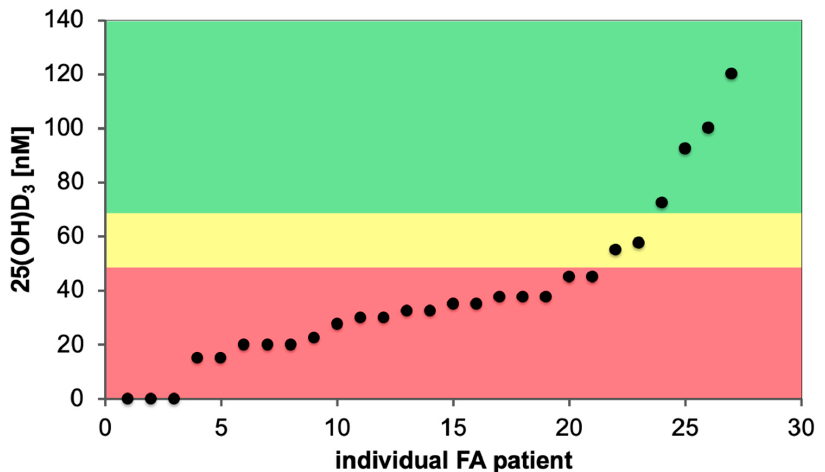
Figure 5. Vitamin D status of FA patients. The serum 25(OH)D 3 concentration of 27 randomly chosen FA patients of a single center are displayed, 21 of which are vitamin D deficient (red), while 2 have an insufficient (yellow) and 4 a sufficient (green) vitamin D status.